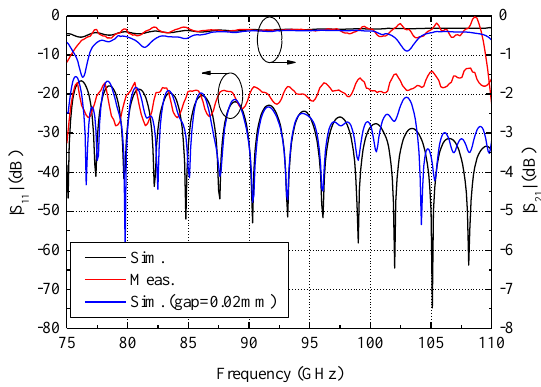
Figure 13. Simulation and measured results of the fabricated prototype.